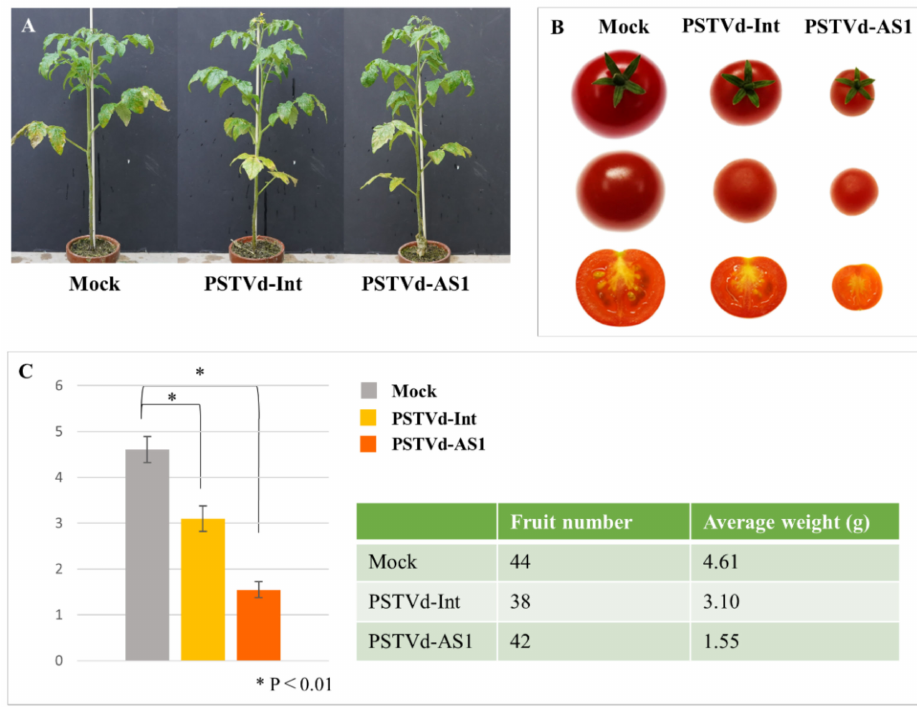
Figure 2. Symptoms of fruits in PSTVd-tolerant ‘Tiny-Tim’ tomatoes. ( A ) ‘Tiny-Tim’ tomatoes did not clearly show morphological symptoms in stems and leaves at 6 weeks post-inoculation. ( B ) The fruits from PSTVd-infected plants became significantly smaller in size and lost their surface luster; in particular, the fruits from PSTVd-AS1-infected plants did not form any seeds. ( C ) The average weight of fruits derived from PSTVd-infected plants was low compared with that from mock-inoculated, but there was no difference in total number of fruits. The significant difference in the fruit weight was confirmed by the Tukey–Kramer